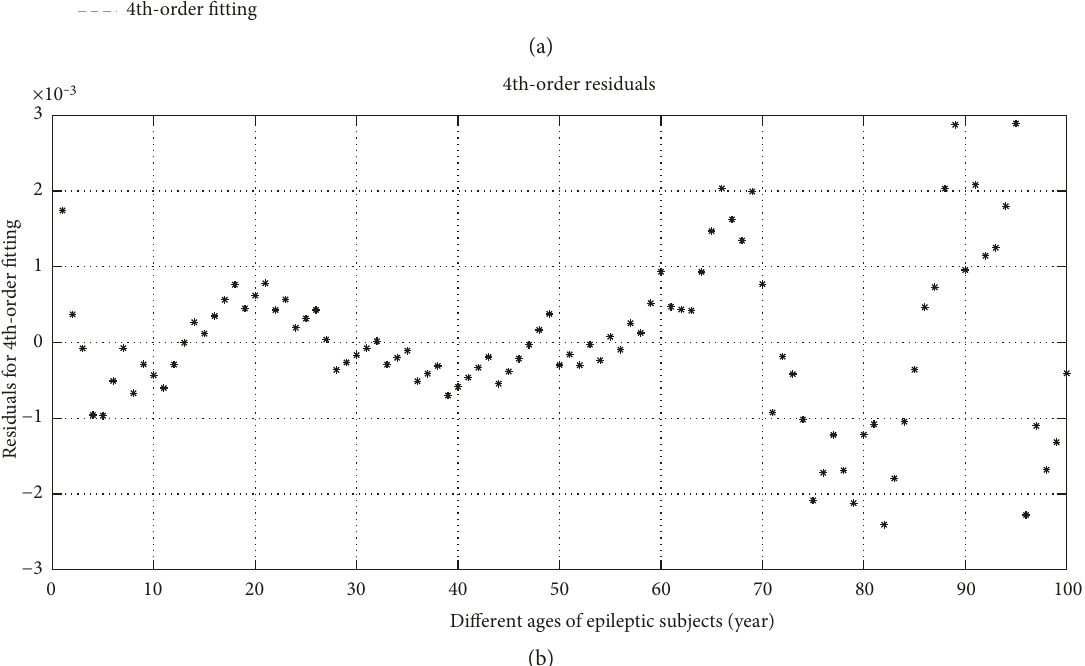
Figure 8: (a) 4th-order fi tting and (b) residual of ApEn with di ff erent ages of